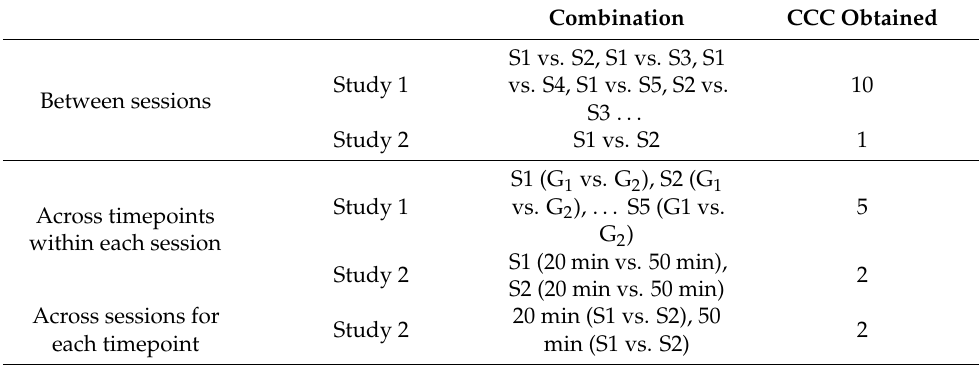
Table 2. Illustration of the combinations used to calculate comparable ICCs and CCCs for validation of